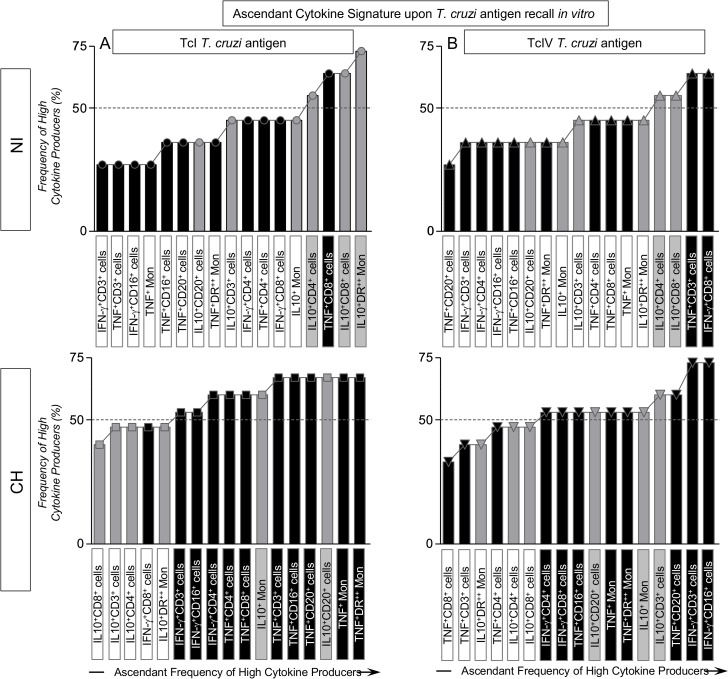
Ascendant cytokine signatures of T. cruzi-infected and non-infected macaques upon (TcI/TcIV)/T. cruzi-antigen recall in vitro.Bar charts and continuous lines were assembled together to characterize the differential impact of (A) TcI (NI = circle symbols; CH = Square symbols) and (B) TcIV (NI = triangle symbols; CH = inverted triangle symbols) T. cruzi antigen recall in vitro on the pro-inflammatory (black rectangle) and modulatory (gray rectangle) cytokine pattern of cynomolgus macaques naturally infected with T. cruzi (CH) and non-infected controls (NI). The ascendant constructions were used to identify the biomarkers with the most prominent contribution for high cytokine producers. The biomarkers with frequencies above the 50th percentile line were tagged by rectangles to highlight the pro-inflammatory (black rectangle) and modulatory (gray rectangle) cytokine-producing leukocyte subset.